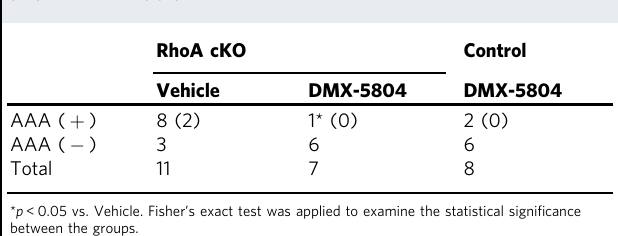
Table 2 Number of mice with or without AAA after treatment with vehicle or DMX-5804 in addition to AngII and BAPN infusion.